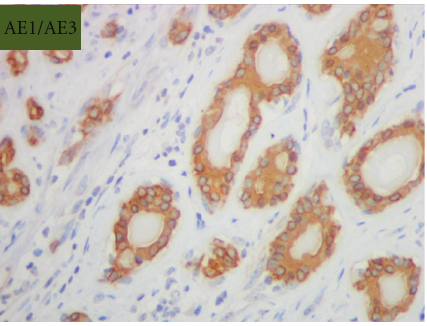
Figure 7: Epithelial stains, AE1/AE3 (original magnification × 400).